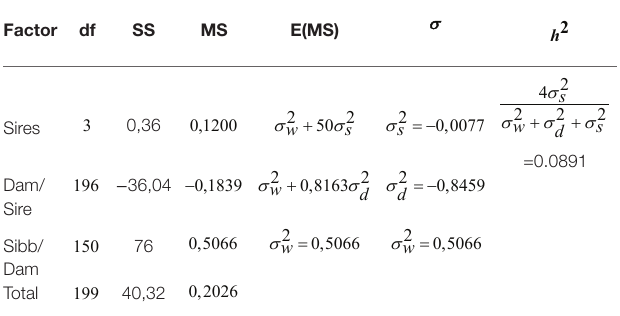
TABLE 5 | ANOVA of the survival to Newcastle disease virus (NDV) infection. TABLE 6 | Effect of the selection of parent for antibody responsiveness to vaccination on the survival of local chicken according to genetic group and